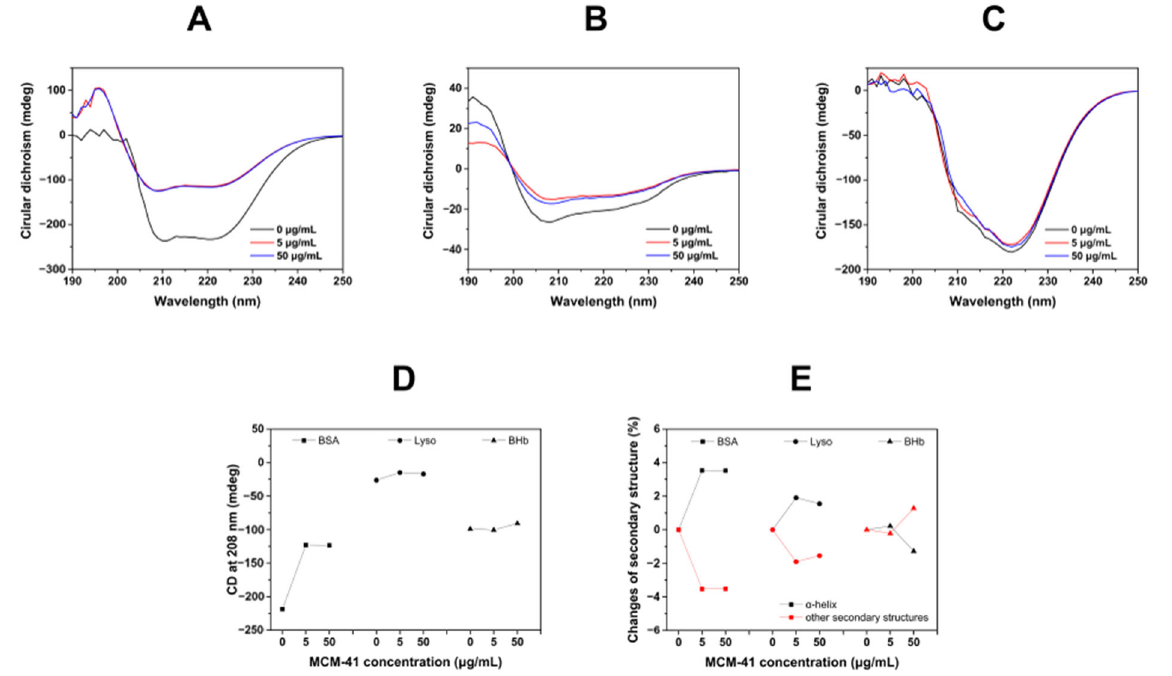
Figure 4. ( A – C ) CD spectra of MCM ‐ 41 incubated with BSA ( A ), Lyso ( B ) and BHb ( C ). ( D ) The CD ellipticity values at 208 nm of different proteins incubated with MCM ‐ 41. ( E ) The changes of α‐ helix and other secondary structures’ contents of different proteins incubated with MCM ‐ 41.